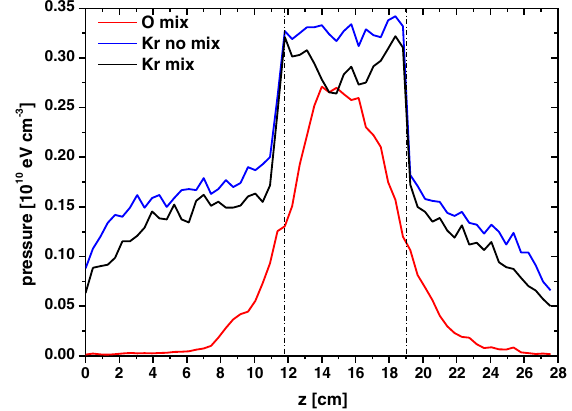
FIG. 8. Ion pressure profiles along the source z axis: pressure of the oxygen ions (red line), pressure of the krypton ions at ffiffiffiffiffiffiffiffiffiffiffiffiffiffiffiffiffiffi p exp ð Q Δ φ =T Þ ; Kr ¼ 95 %, O ¼ 5 % (black line), and pressure of the krypton iQ 2 T =M iQ i ions at Kr ¼ 100 % (blue